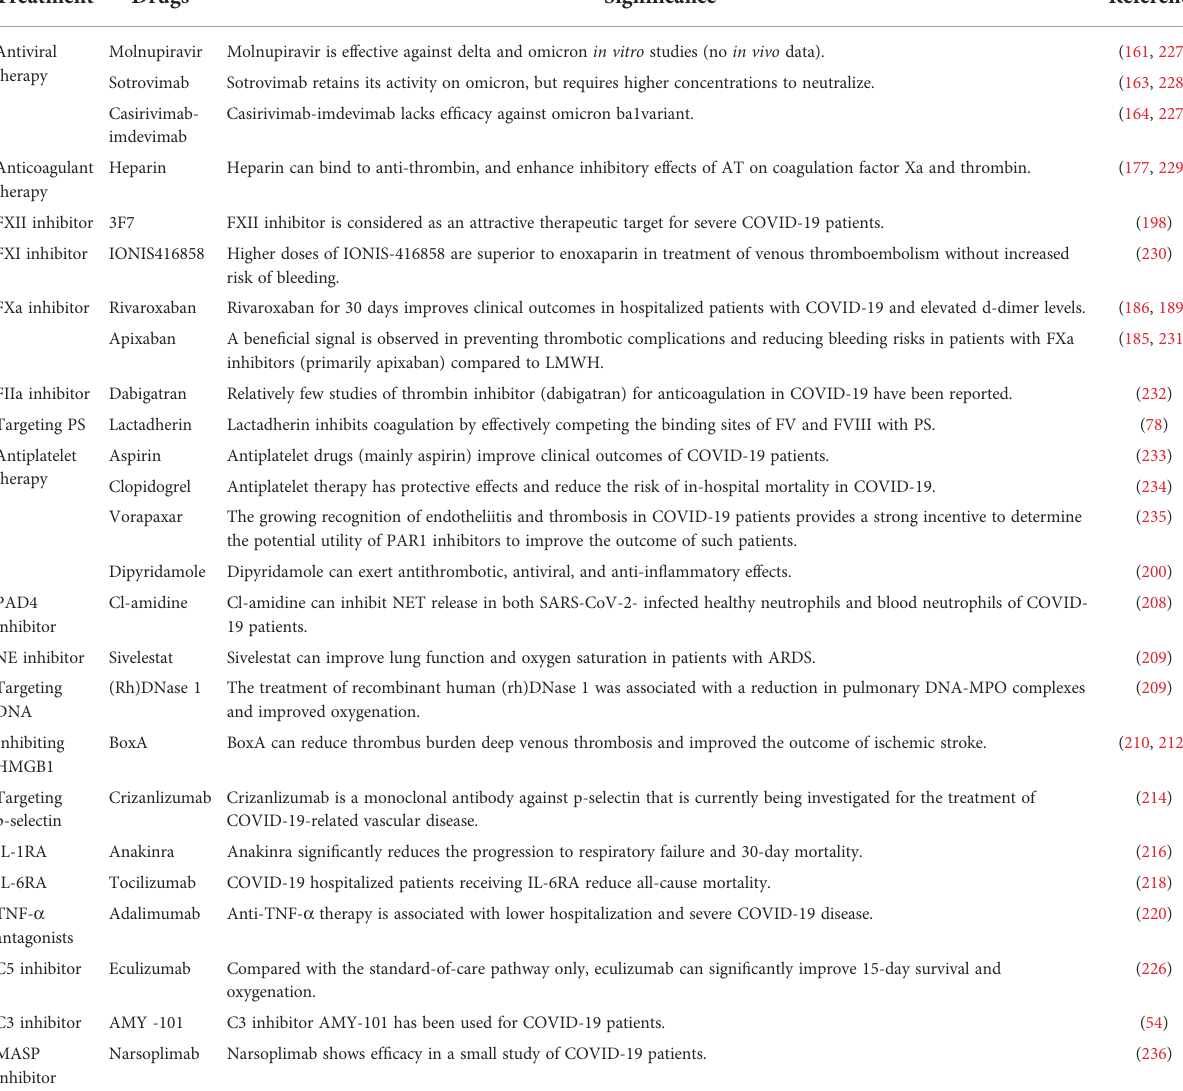
TABLE 1 Prevention and treatment strategies for COVID-19 patients. Treatment Drugs Signi fi cance Reference Antiviral